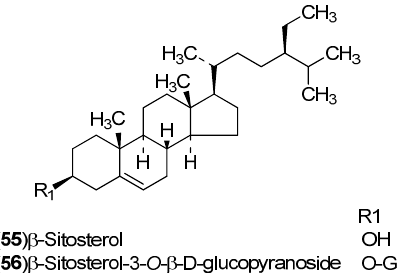
Figure 2. Chemical structures of steroids.